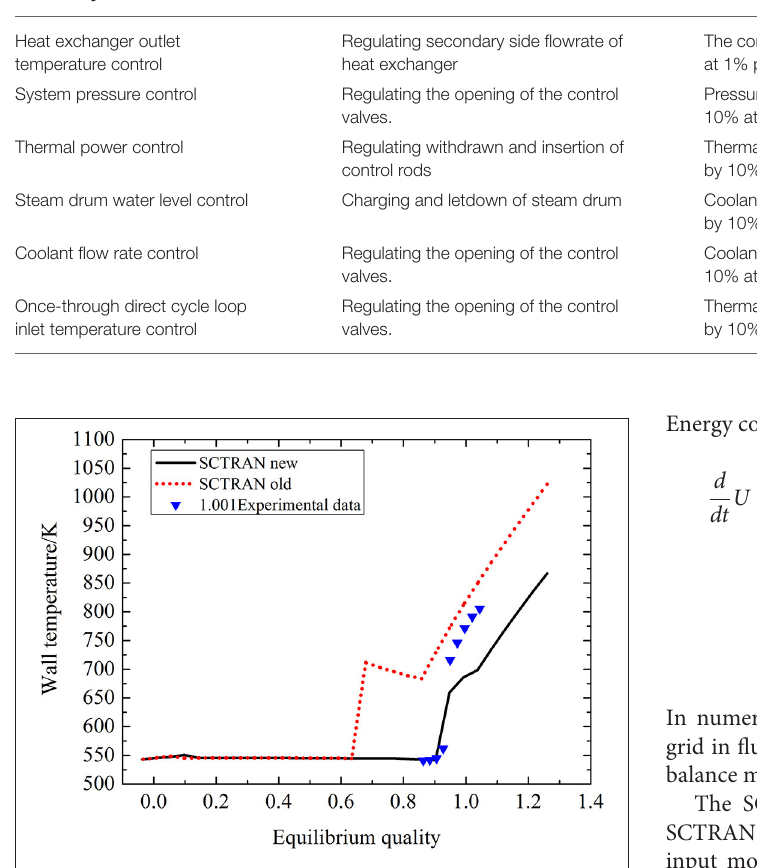
FIGURE 7 | Variation of the Wall Temperature in Subbotin